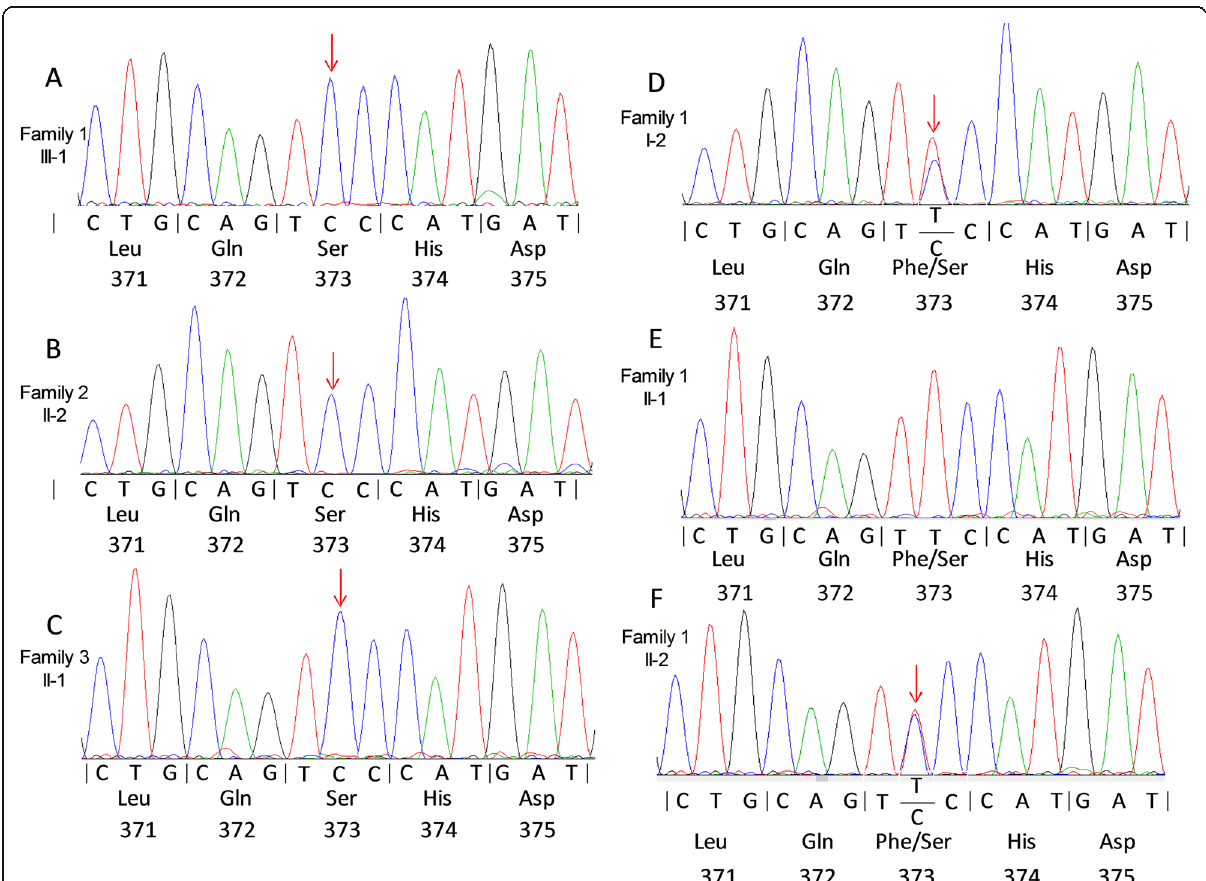
Fig. 3 G6PD gene variant analysis in three families. a - c The sequence data are shown for the c.1118 T > C variant of G6PD gene exon 9 in the proband (II-1) of family1 ( a ), family 2 (II-2) ( b ) and family 3 (II-1) respectively. d - f the sequence data are presented for the c.1118 T > C variant in the mother or grandmother of the family1 (I-2) ( d ), (II-1) ( e ) and II-2 ( f